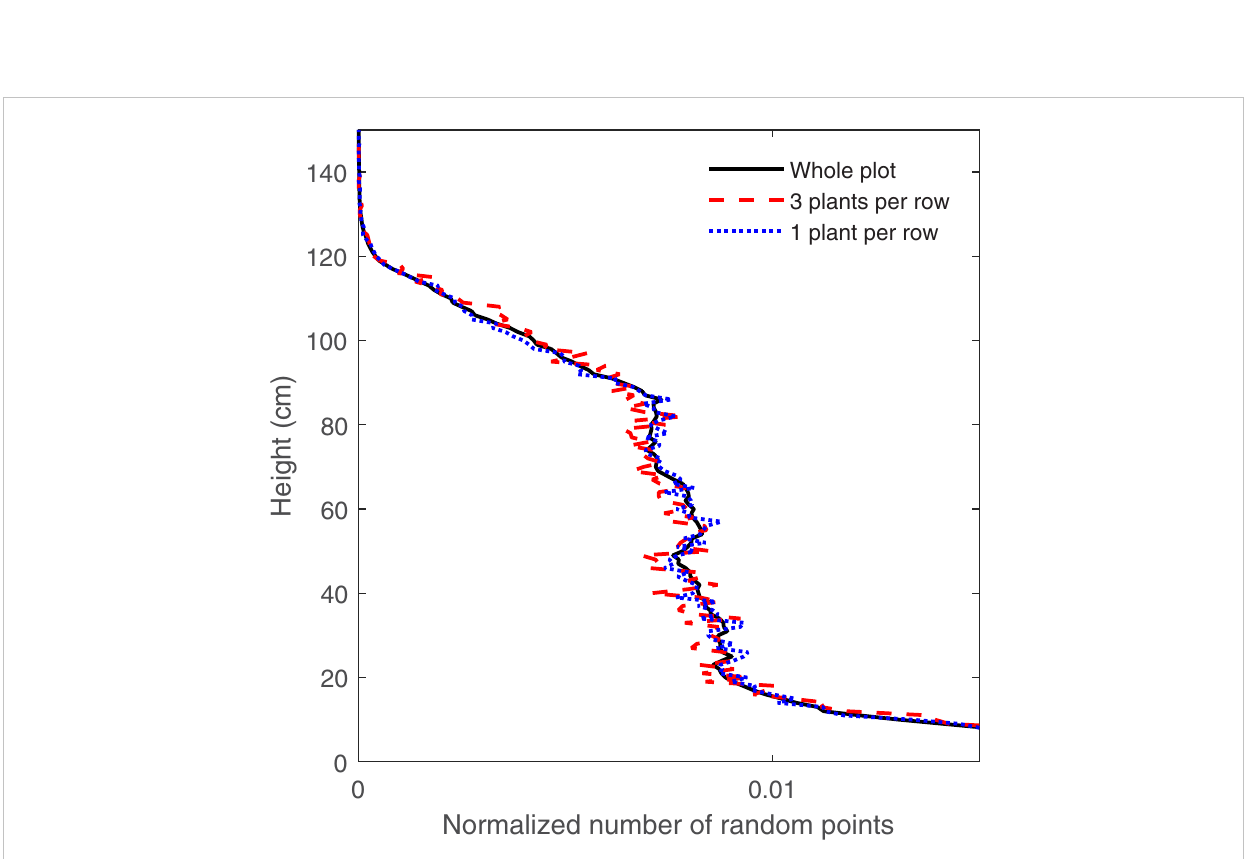
FIGURE 9 The CVP obtained from LiDAR data provided with three different numbers of plants per